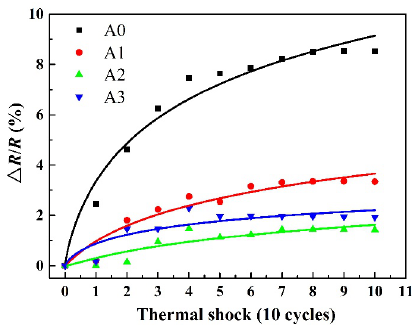
Fig. 14 Relative resistance drift of MCNS ceramics under thermal shock